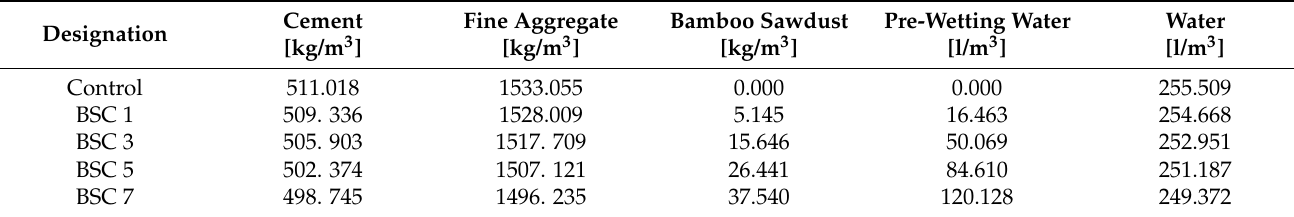
Figure 2. BS particle water-absorption rate. Table 2. Compositions of different formulations.